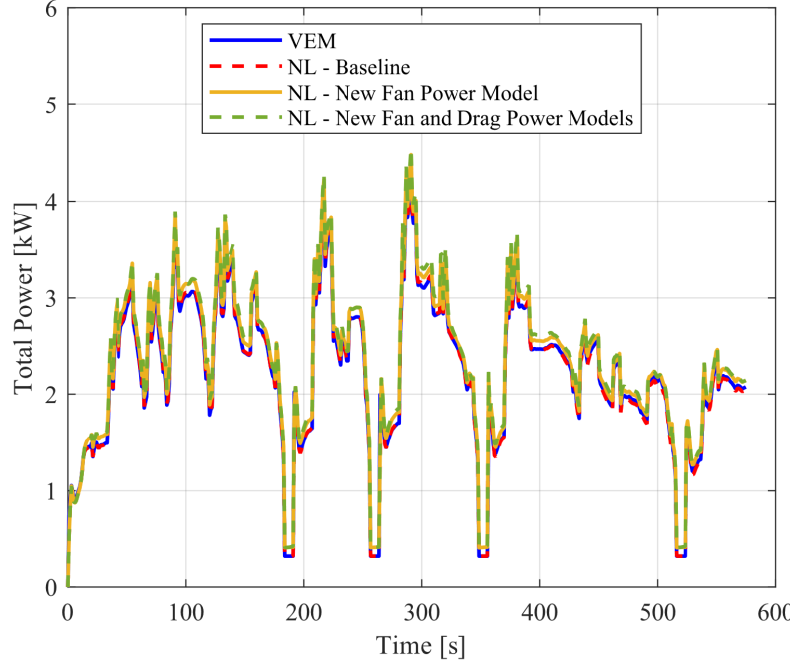
Figure 7. Total power consumption comparison for the SC03 drive cycle. Table 6. Energy consumption comparison for SC03 cycle.